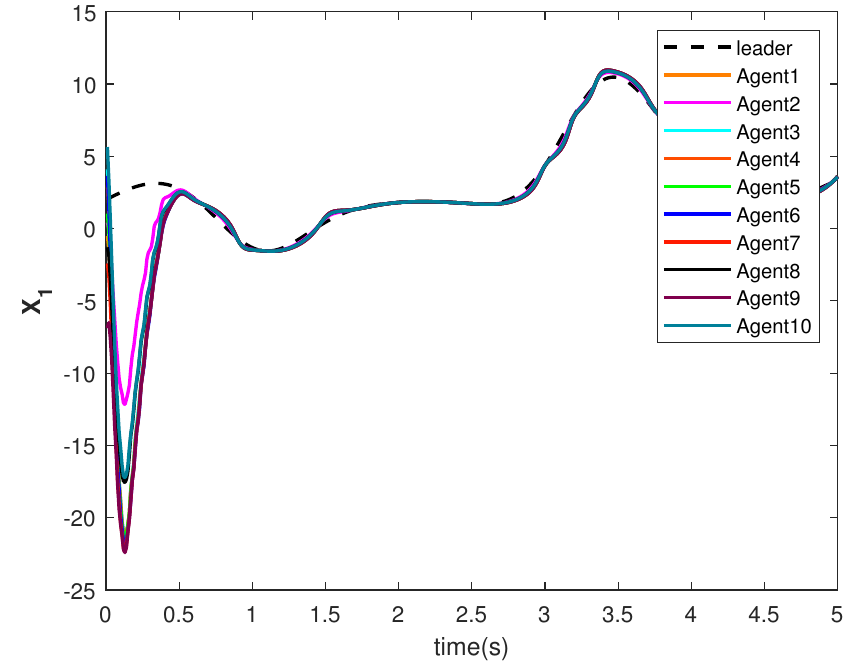
Figure 9. Consensus tracking of state X 1 of the